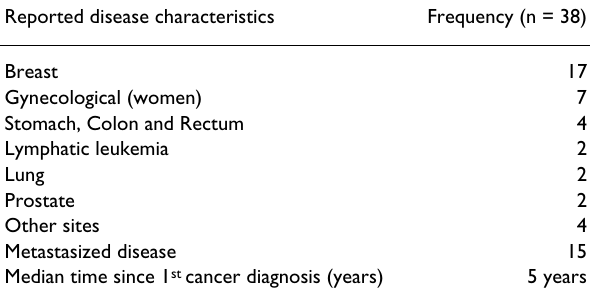
Table 2: Reported disease characteristics. Reported disease